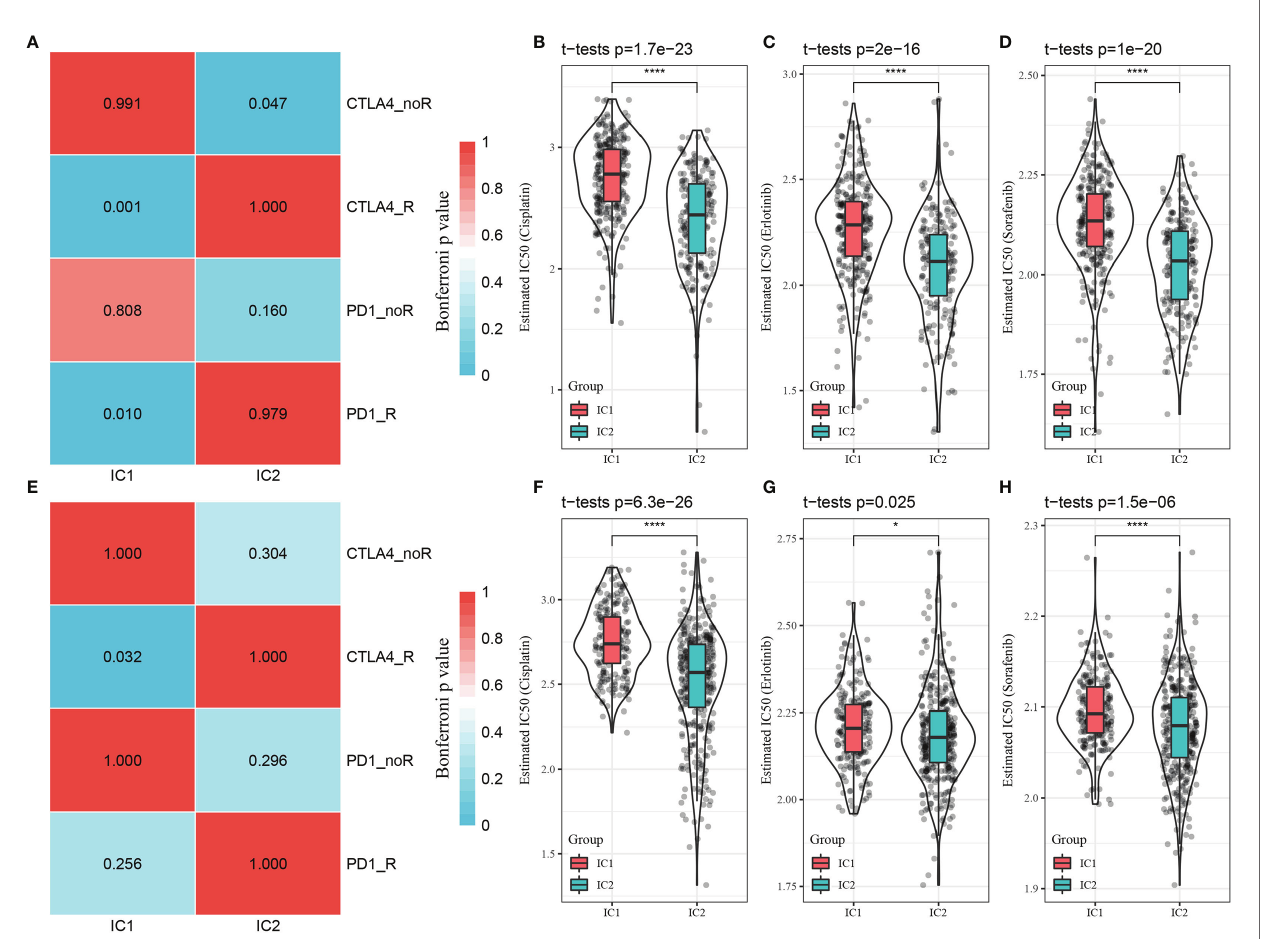
FIGURE 8 | Differential analysis of immunotherapy/chemotherapy response of molecular subtypes. (A) TCGA-LUAD submap analysis indicating that patients with the IC1 subtype could be more sensitive to CTLA4 and PD-1 (Bonferroni-corrected p < 0.05). (B – D) Box plots of estimated IC50 values in the TCGA-LUAD dataset. (E) GSE-LUAD submap analysis indicating that patients with the IC1 subtype could be more sensitive to CTLA4 (Bonferroni-corrected p < 0.05. (F – H) Box plots of estimated IC50 values in the GSE-LUAD dataset. *p < 0.05; ****p <